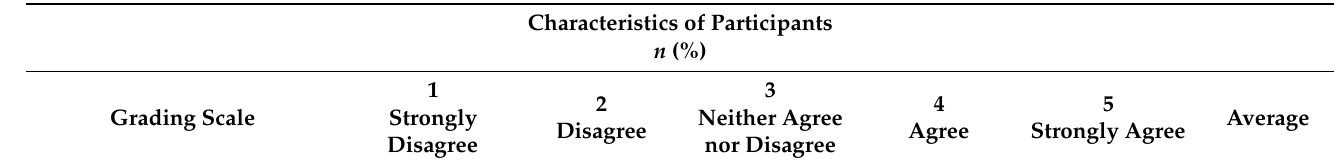
Table 2. Nurses’ previous experience in the field of cooperation with a pharmacist in